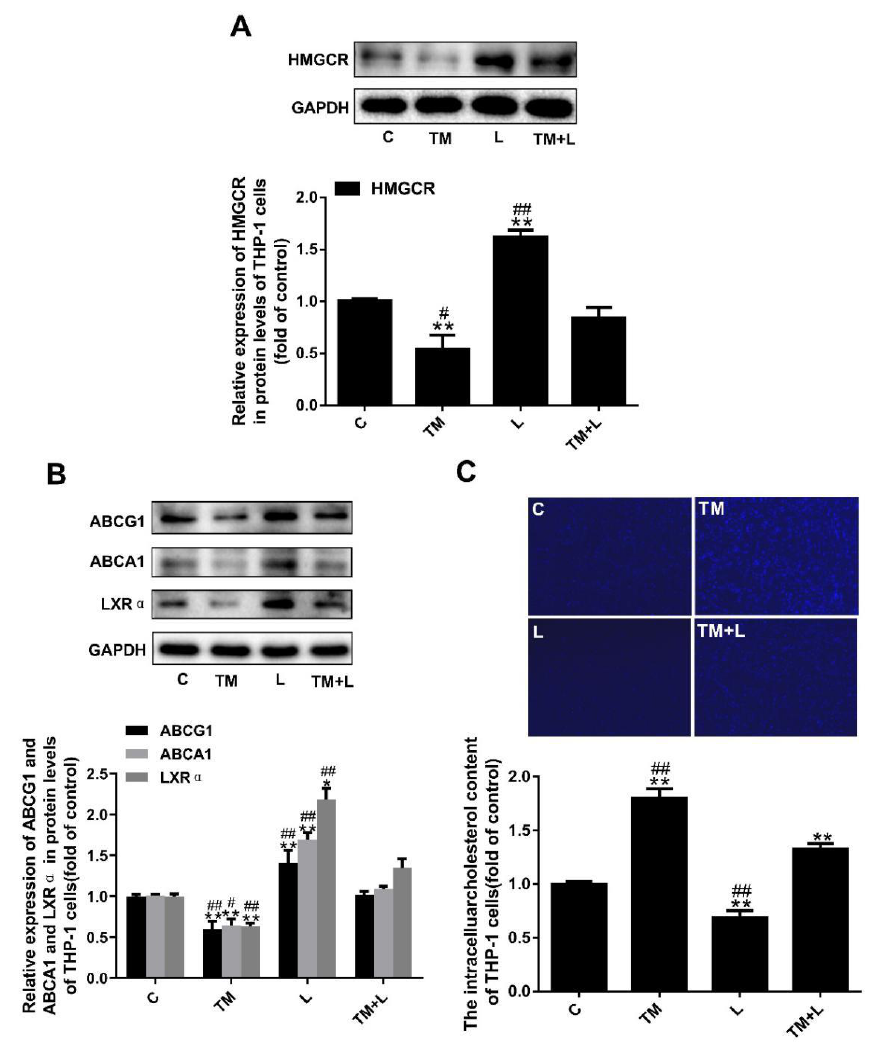
Figure 7. Tunicamycin-induced ER stress reduced cholesterol efflux in THP-1 macrophages, and LXR-623 inhibited this effect. ( A ) Expression levels of HMGCR in THP-1 macrophages. ( B ) Expression levels of ABCA1, ABCG1 and LXRα in THP-1 macrophages. ( C ) Filipin staining of THP-1 macrophages. C, control; TM, tunicamycin; L, LXR-623; TM + L, tunicamycin + LXR-623. Data are shown as the mean ± SD ( n = 3), * p < 0.05 or ** p < 0.001 versus the C group. # p < 0.05 or ## p < 0.001 versus